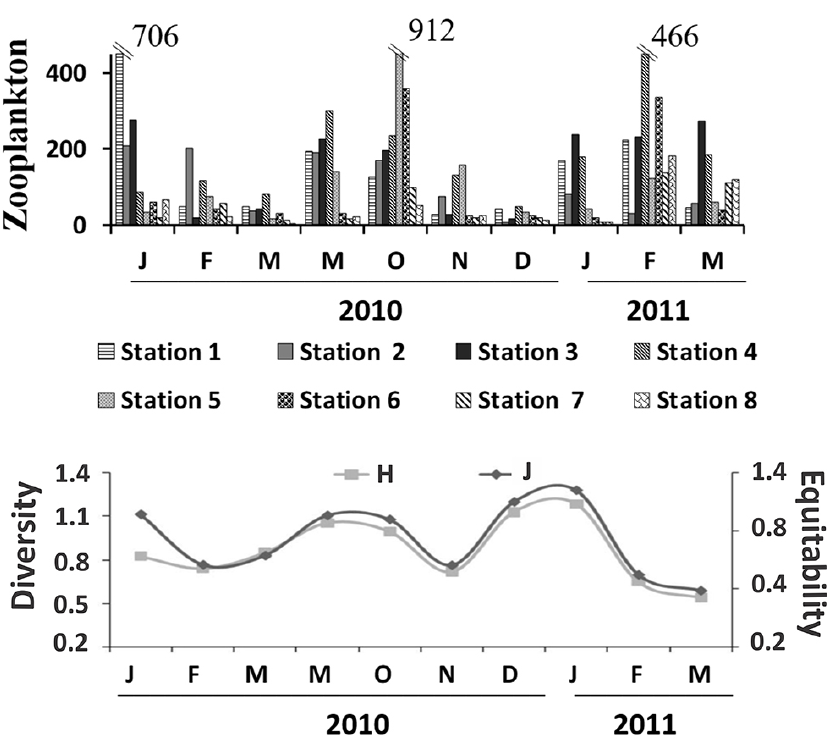
Figure 5. Variation of zooplankton density in each collection station, variations in the index of Shannon-Weaver which measures the Diversity (H) and the Pielou’s uniformity which measures the Equitability (J) over the sampled